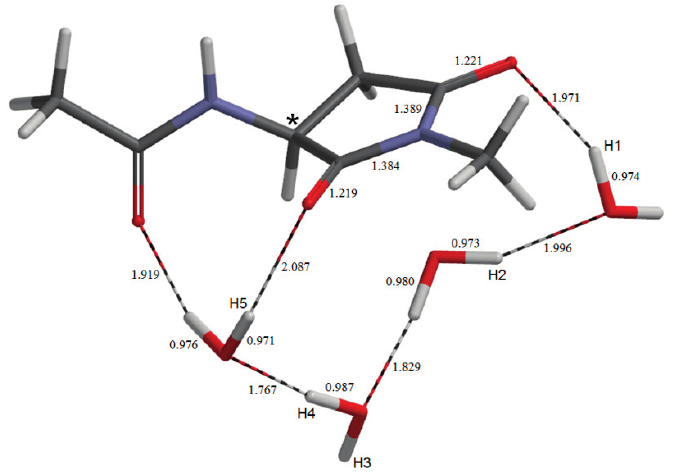
Figure 12. The geometry of the succinimide product SI . Selected bond distances are shown in Å.